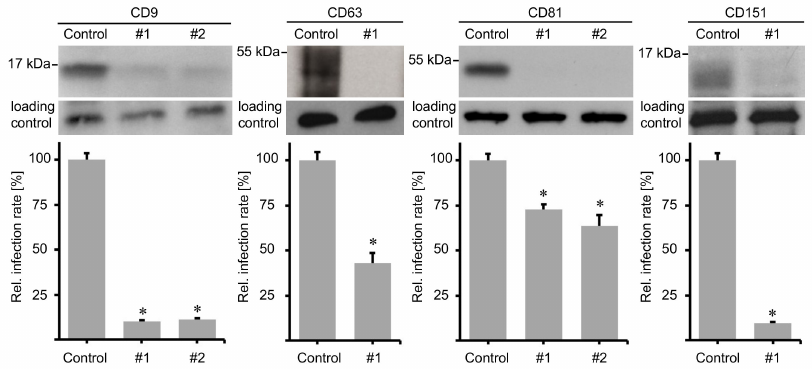
Figure 1. Tetraspanins CD9, CD63, CD81, and CD151 are required for HPV16 infection. HeLa cells were treated with control, tetraspanin CD9, CD63, CD81 or CD151 specific siRNAs (#1 or #2) for 48 h, then infected with HPV16 PsVs for 24 h. Upper panels show siRNA knockdown efficiency ( β -actin served as loading control). Graphs presented on the lower panels show relative infection rates assessed by measuring luciferase activity since HPV16 PsVs harbor a luciferase expression plasmid. Data sets are shown as mean ± standard error of the mean (SEM) and were normalized to the mean of control siRNA treated cells (set to 100%). Asterisks indicate significant differences to the control ( p <